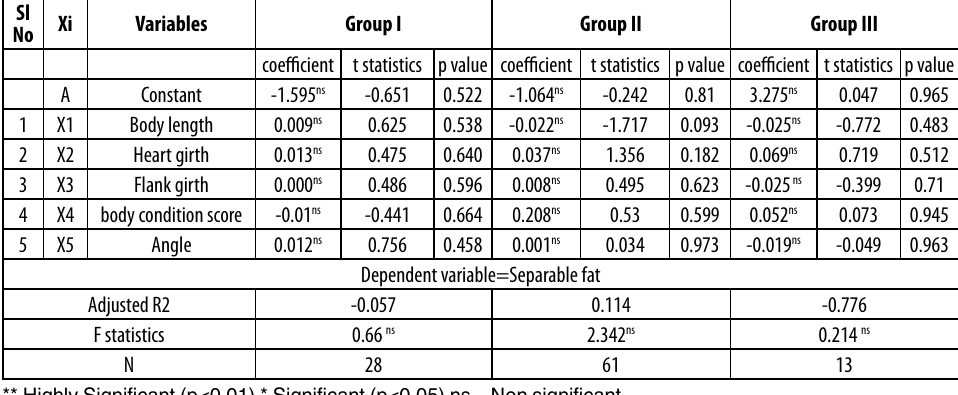
table 7. Regression analysis for developing prediction equation for per cent separable fat using live animal physical body measurements in three different weight groups Sl Xi No